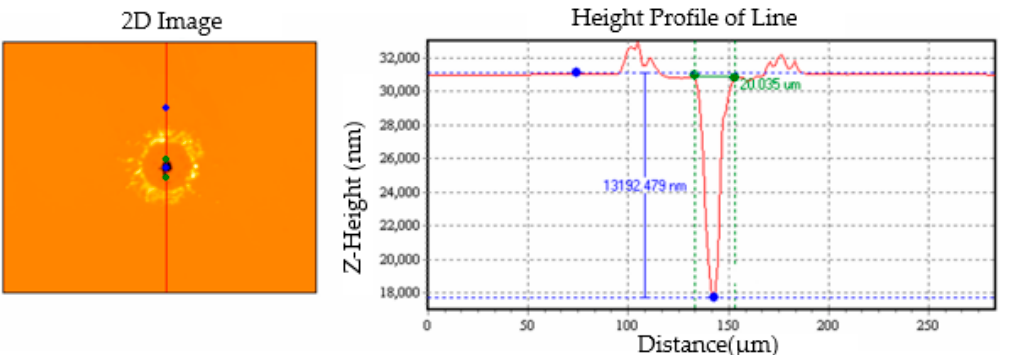
Figure 2. Depth measurement using the white-light interferometer.